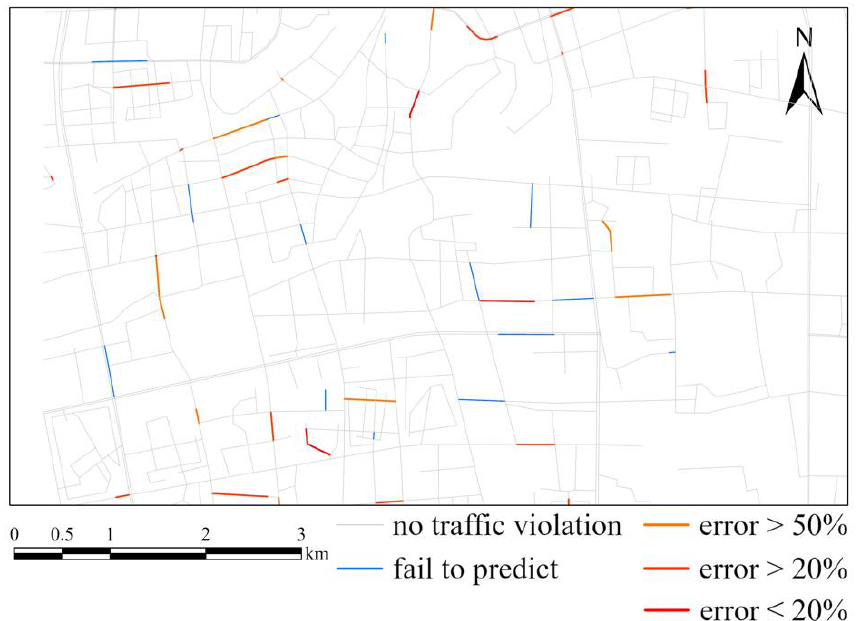
Figure 13. Comparison of GATR improved by urban functional feature and truth. Blue lines repre- sent roads having traffic violations but not predicted by GATR. Red lines represent well predicted roads.